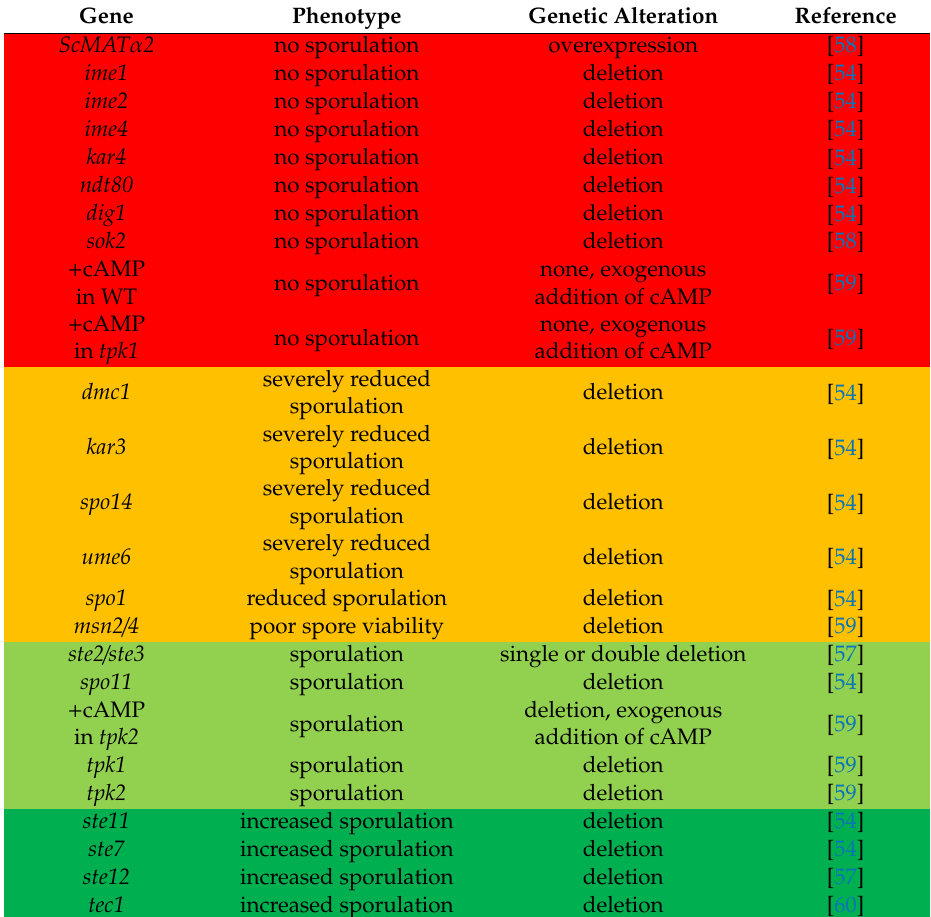
Note: background color identifies di ff erential sporulation